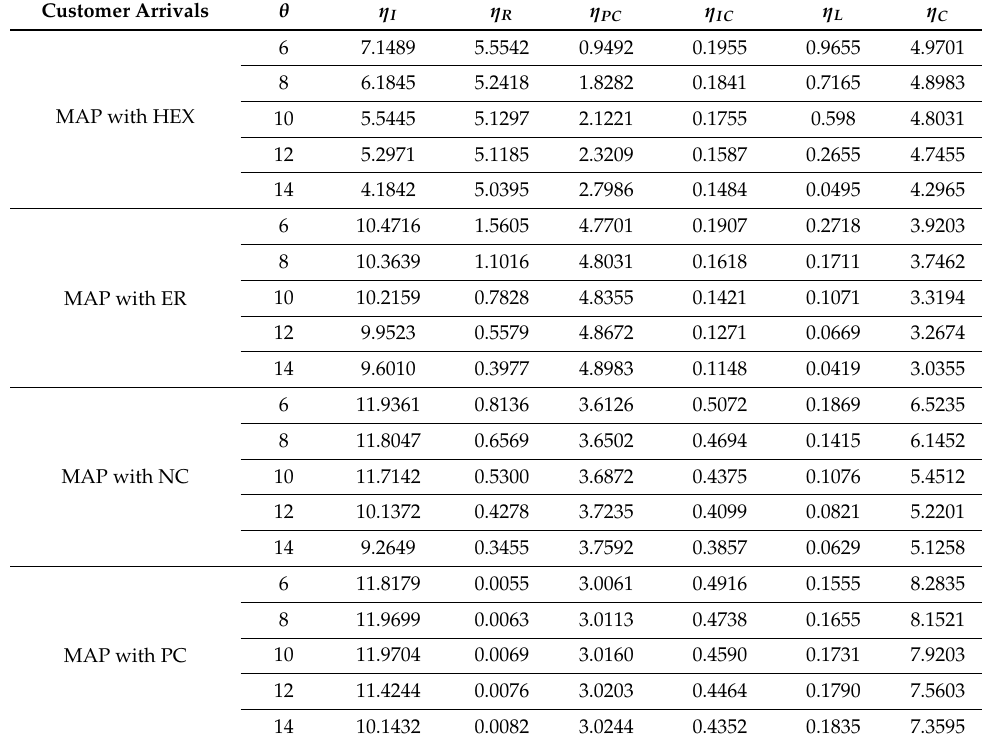
Table 5. Ramification of MAP with ER, NC and PC for ( S , s , µ , β ) = (21, 7, 2.5, 0.1).